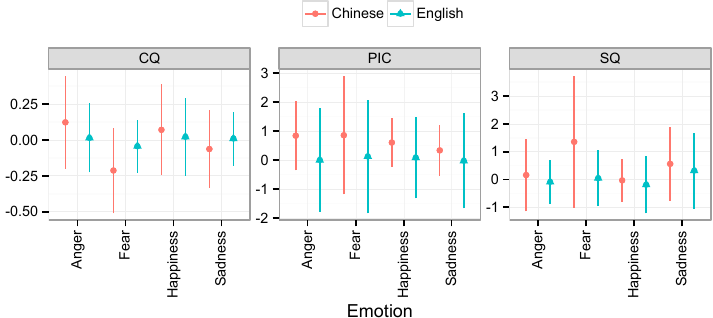
Figure 5. Physiological measures of phonation of four emotions in Mandarin and English. Points indicate mean values and error bars 95% confidence intervals (Adapted from Figure 3 in Reference [31]).